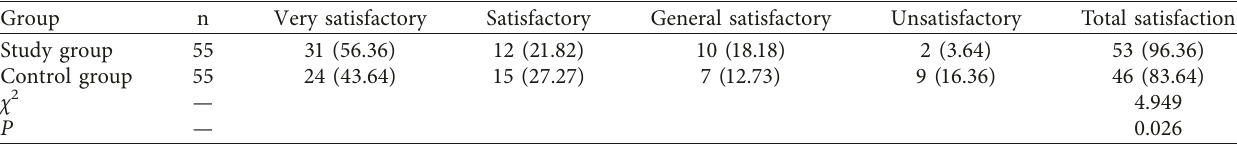
Table 5: Comparison of patients’ satisfaction with emergency care between the two groups (n, %).